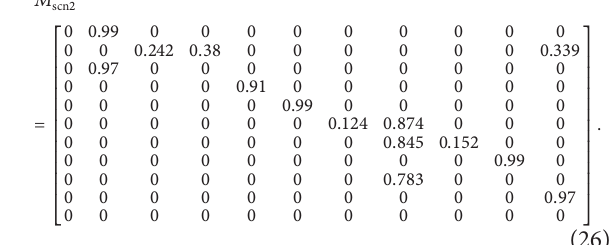
Table 2: Abstract service transition probability. Abstract srv trans.